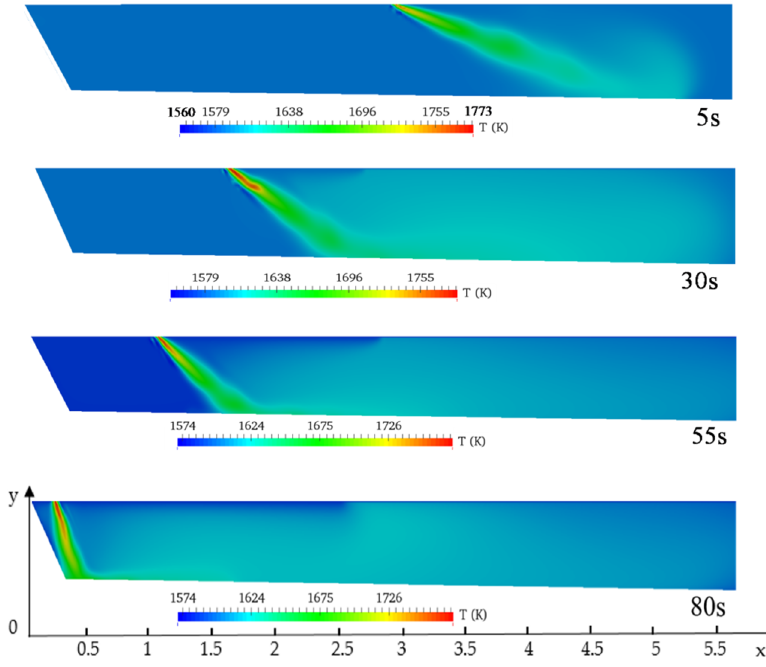
Figure 7. Wall shear stress on the line 1 (blue curve, cf. Figure 3b) and line 2 (red curve, cf. Figure 3b).